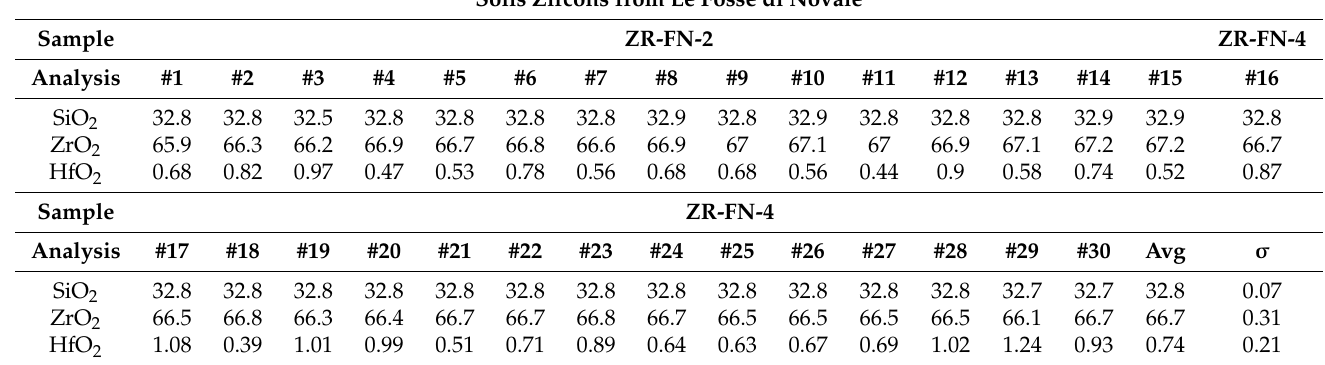
Table 2. Representative EMPA analyses of the zircons from Le Fosse di Novale. TiO 2 , Nb 2 O 5 and Y 2 O 3 are below detection limits (<0.01–0.05 wt %).